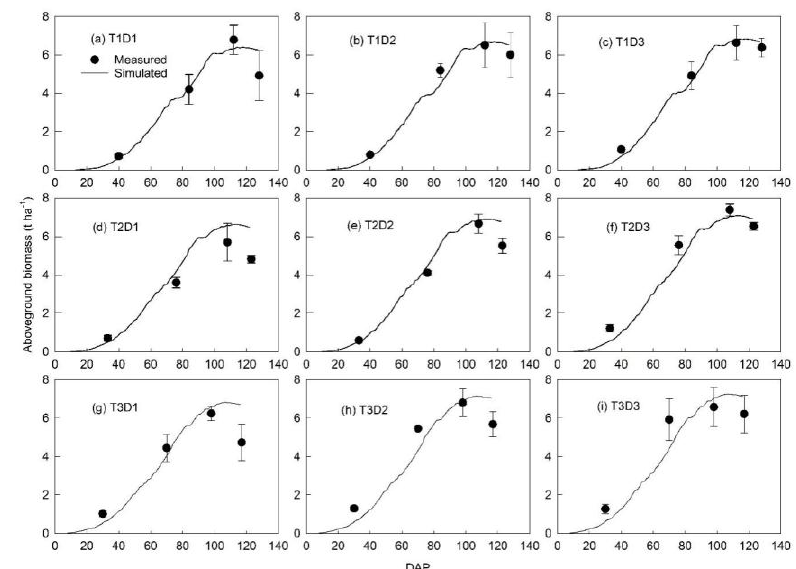
Figure 8. Simulated and measured aboveground biomass of peanut under ( a ) T1D1, sowing on 25 April with 24 plants m − 2 , ( b ) T1D2, sowing on 25 April with 30 plants m − 2 , ( c ) T1D3, sowing on 25 April with 36 plants m − 2 , ( d ) T2D1, sowing on 5 May with 24 plants m − 2 , ( e ) T1D1, sowing on 5 May with 30 plants m − 2 , ( f ) T1D1, sowing on 5 May with 36 plants m − 2 , ( g ) T1D1, sowing on 15 May with 24 plants m − 2 , ( h ) T1D1, sowing on 15 May with 30 plants m − 2 , ( i ) T1D1, sowing on 15 May with 36 plants m − 2 during 2018. Values are means of three replicates. DAP is the number of days after planting.